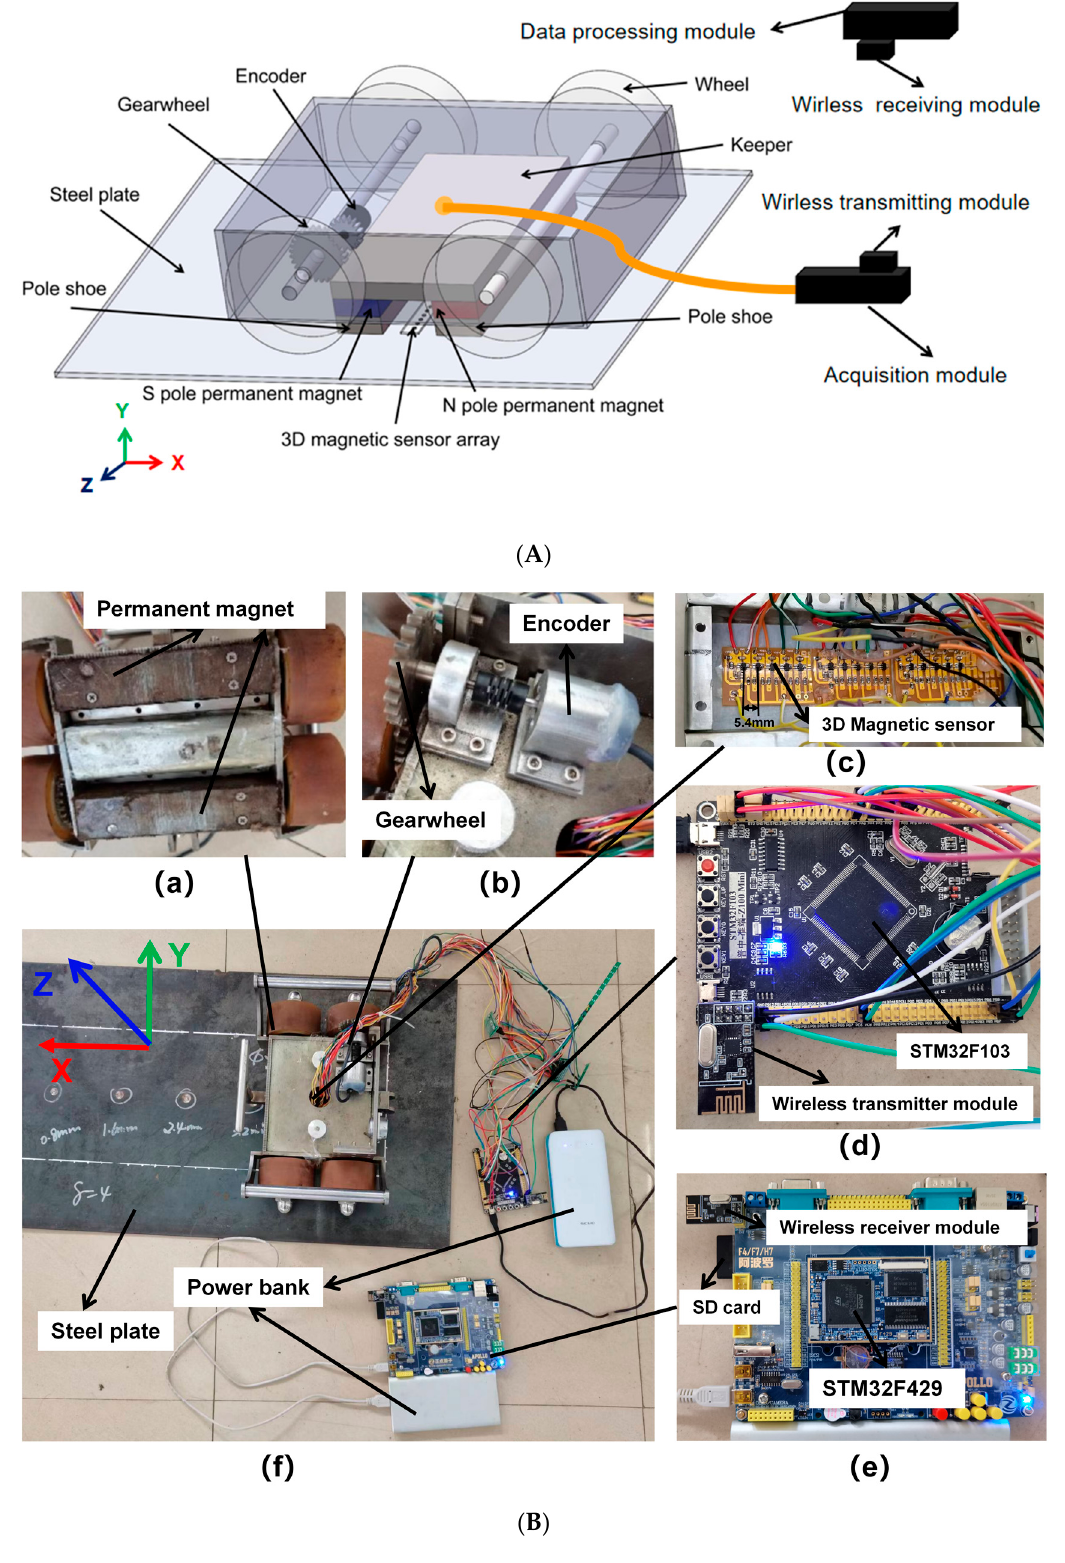
Figure 3. Experimental setup. ( A ) Schematic diagram of the experimental apparatus; ( B ) the actual picture of the experimental device.